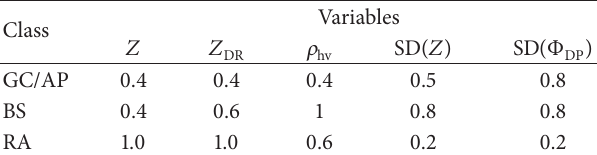
, Φ , and 𝜌 and height for BSb, BSi, DR DP hv